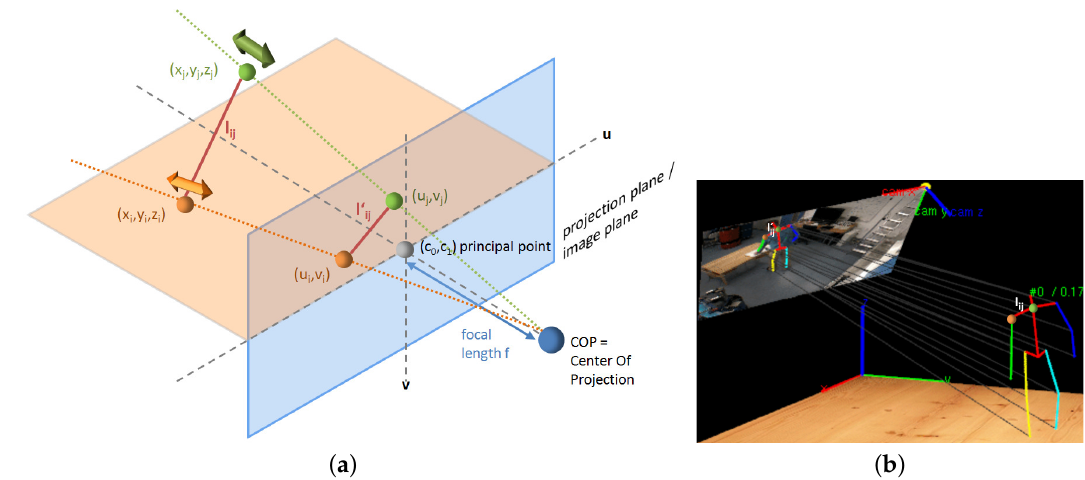
Figure 11. Geometric Reconstruction of 3D Poses. ( a ) Perspective camera models; ( b ) An example pose and its